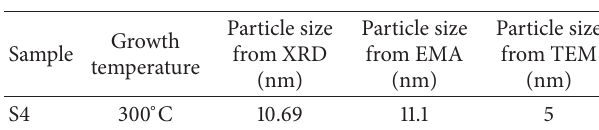
Table 3: Average grain size obtained from XRD, EMA, and TEM analysis.